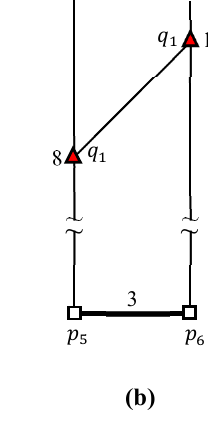
Figure 6. maxdist ( q 1 , { p 4 p 5 , p 5 p 6 } ) = 11 and mindist ( q 1 , { p 4 p 5 , p 5 p 6 } ) = 5: ( a ) maxdist ( q 1 , p 4 p 5 ) = 8 and mindist ( q 1 , p 4 p 5 ) = 5; ( b ) maxdist ( q 1 , p 5 p 6 ) = 11 and mindist ( q 1 , p 5 p 6 ) = 8.